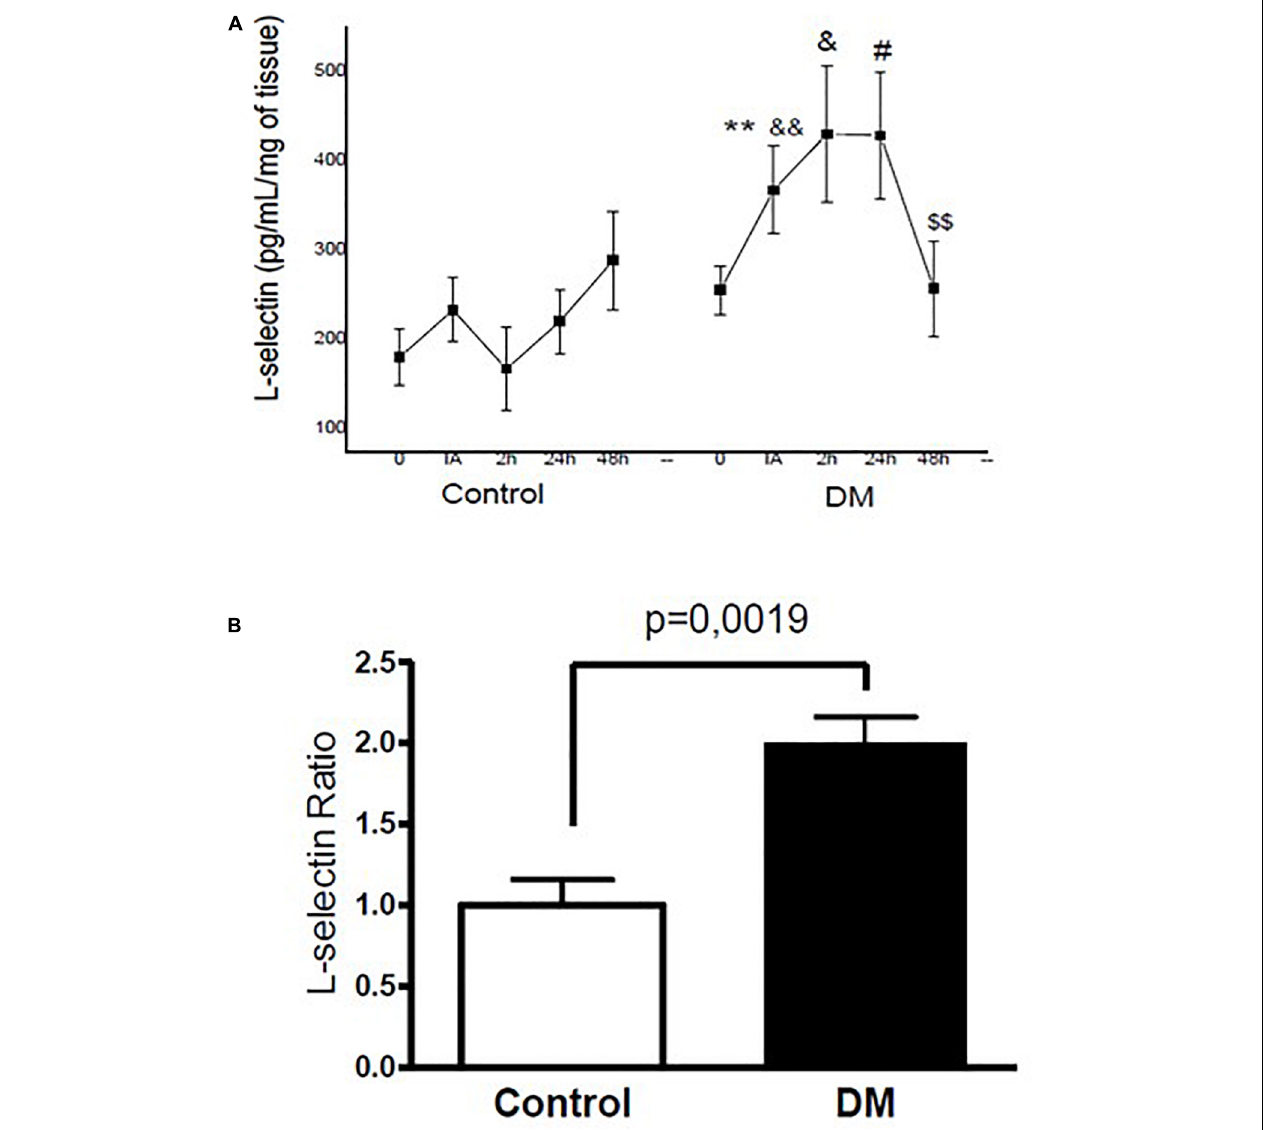
FIGURE 3 | (A) Kinetic profiles of the L-selectin concentration in the skeletal muscle of control and diabetic animals assessed before (0), immediately after (IA), and at 2 h (2), 24 h (24), and 48 h (48) after exercise. (B) L-selectin ratio of the IAUC between control and diabetic rats. The values represent the means ± SE of seven animals per group. ** < 0.05 versus IA (control); & < 0.05 versus 2 h (control); # < 0.05 versus 24 h (control); && < 0.05 versus 0 h (control); $$ < 0.05 versus 24 h